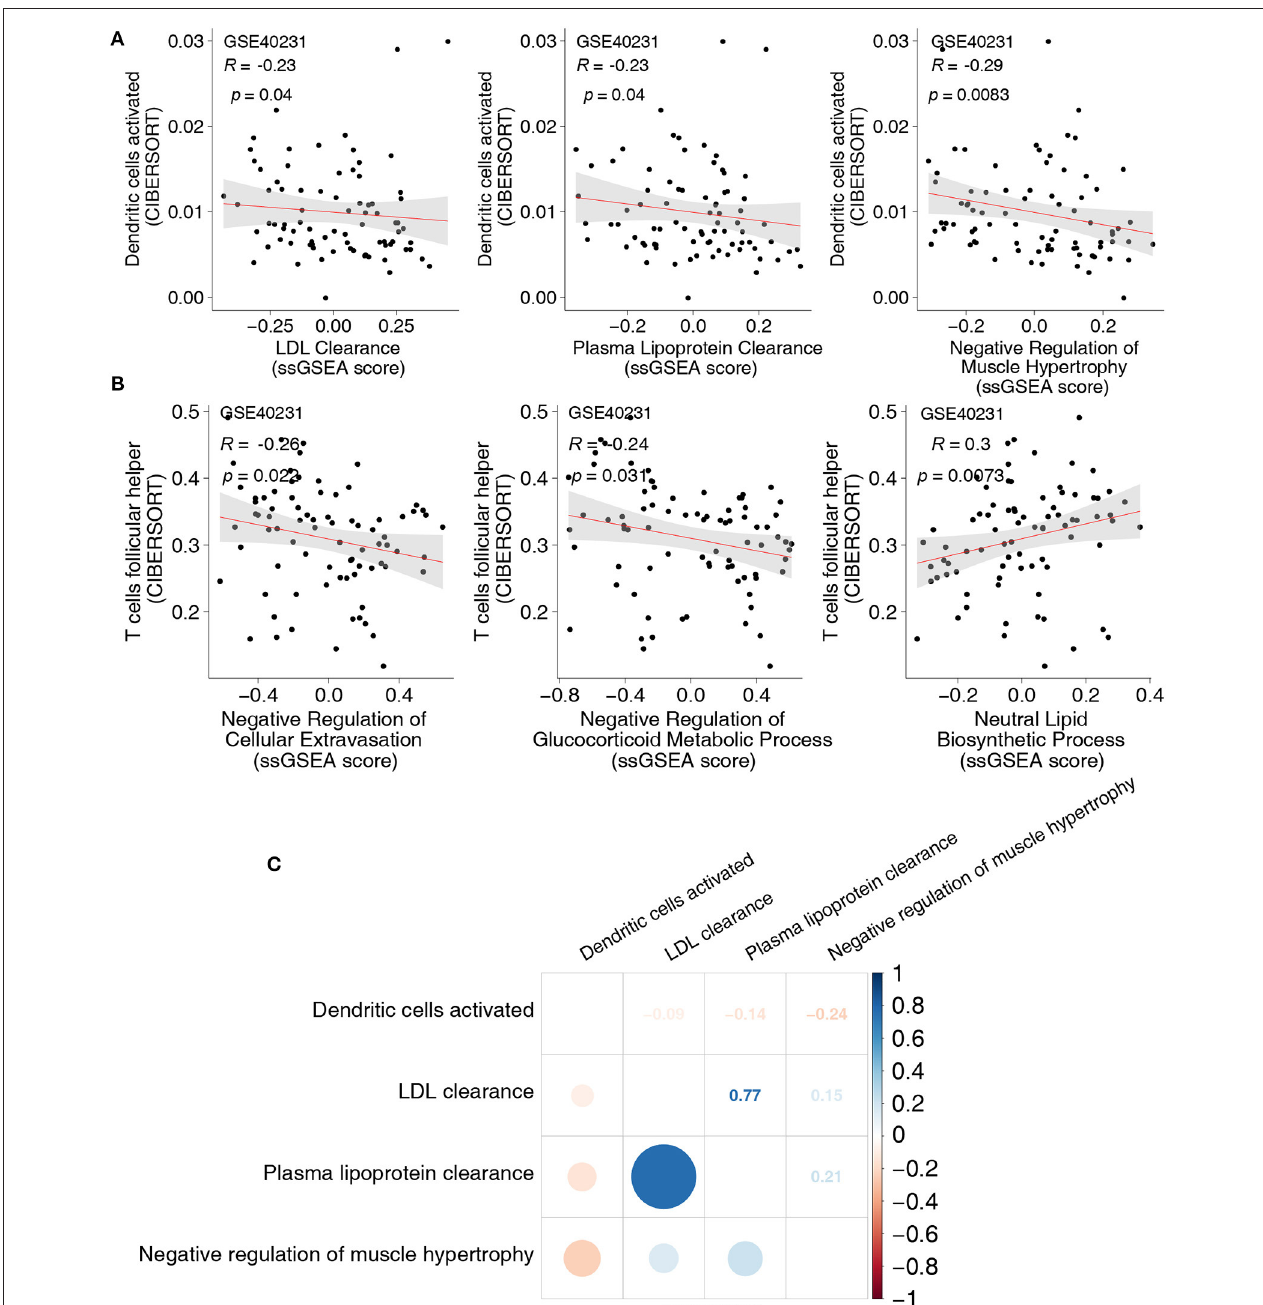
FIGURE 3 | (A) The correlation between the proportions of activated DCs and the score of ssGSEA in GSE40231. (B) The correlation between the proportions of Tfhs and the score of ssGSEA in GSE40231. (C) The correlation heatmap of the proportions of activated DCs and the score of ssGSEA in each three-gene expression dataset (GSE40231). DCs, dendritic cells; Tfhs, T follicular helper cells; ssGSEA, enrichment